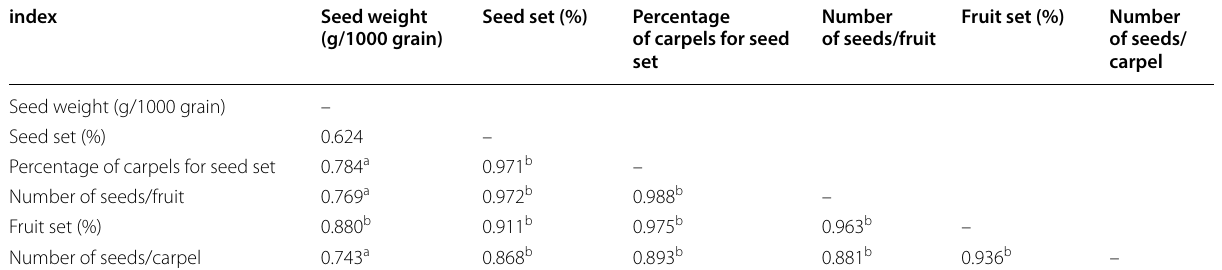
Table 3 Correlation analysis among seed weight (g/1000 grain), seed set, percentage of carpels for seed set, number of seeds/fruit, fruit set, number of seeds/carpel in P. decomposita